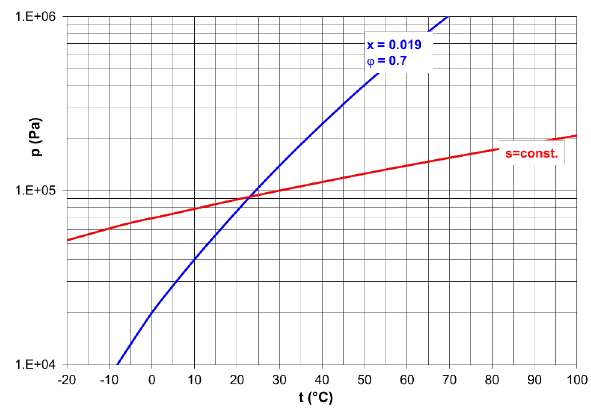
Fig. 4. p − t phase diagram of the moist air with the specific humidity x = 0 . 001 kg V / kg DA and the isentrope ( s = const . ) crossing the point of the state t a = 30 ◦ C , p a = 0 . 1 MPa and ϕ = 70% .